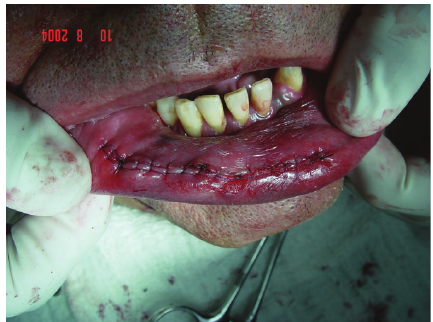
Figure 7: Continuous suture with resorbable thread.